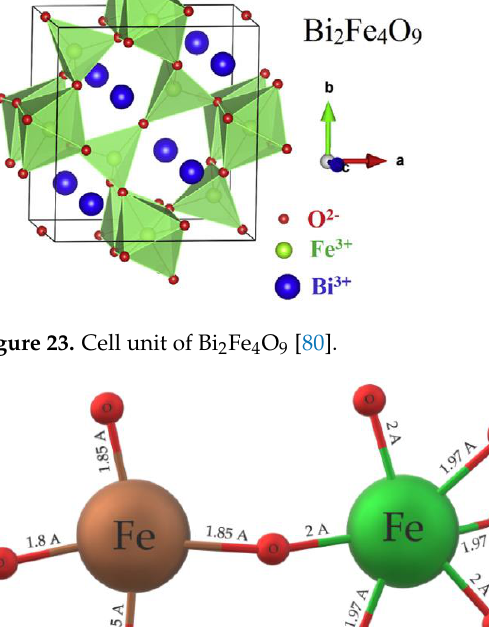
Figure 24. The cell unit of Bi 2 Fe 4 O 9